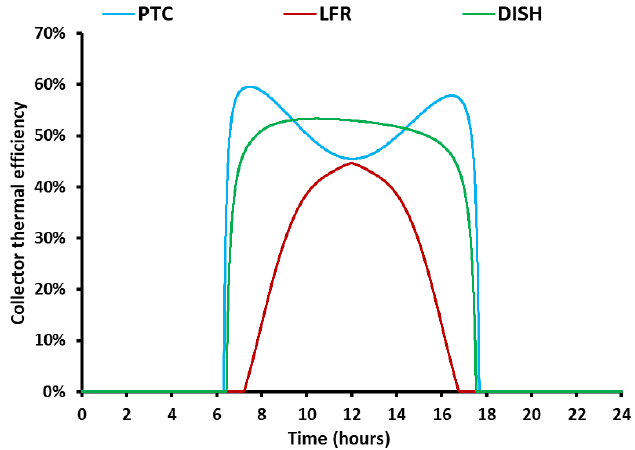
Figure 4. Daily variation of the collector thermal efficiency for the three collectors in June.